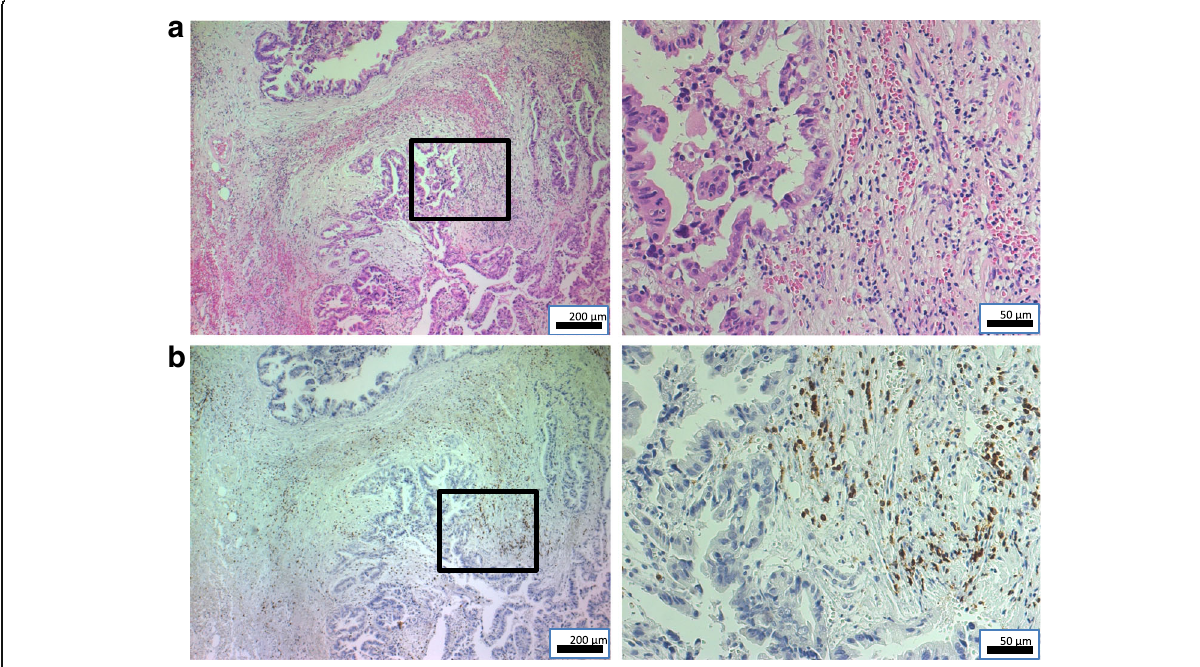
Fig. 1 Representative hematoxylin – eosin-stained images and CD3 + immunohistochemistry results in primary gallbladder cancer specimen. a Specimen with tumor-infiltrating lymphocytes. Right: × 200; left (insert): × 50. b Lymphocytes infiltrate tumor stroma. Brown chromogen: CD3 + T cells. Right: × 200; left (insert): ×